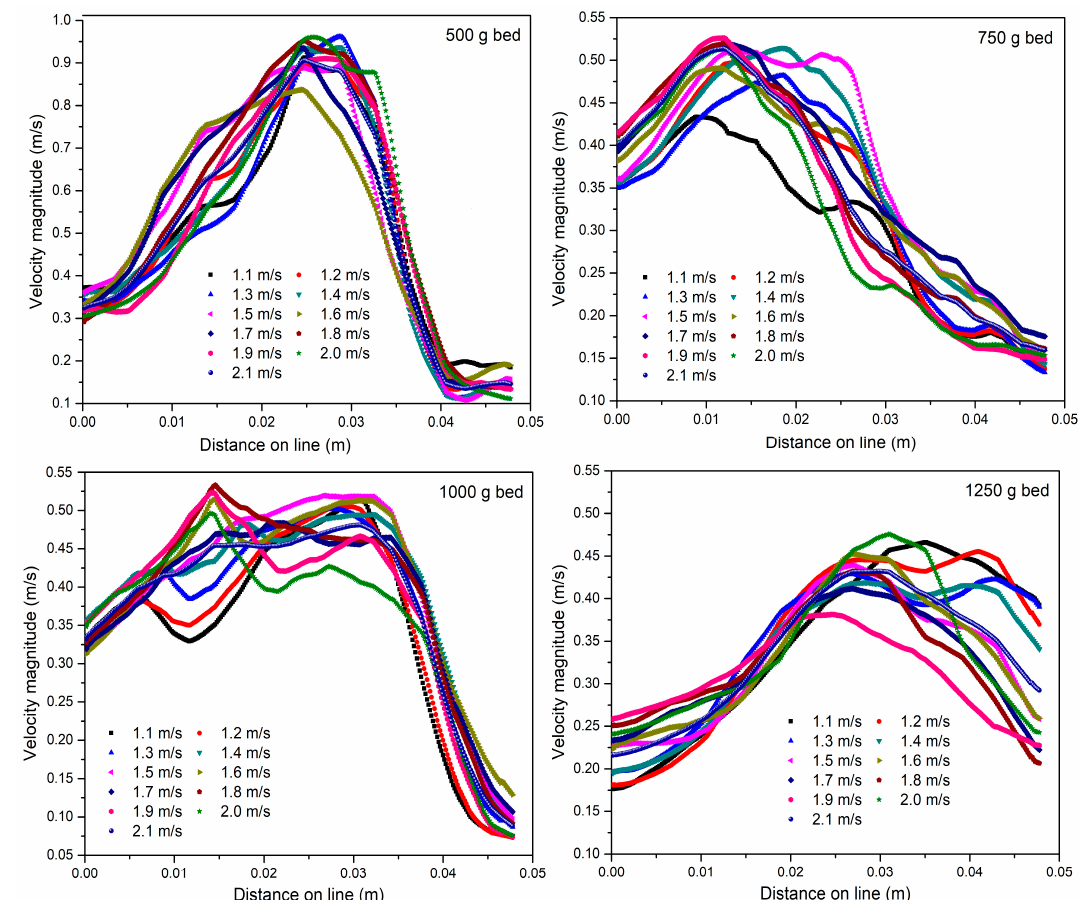
Figure 9. Trend of bed velocity magnitude on radial lines for different superficial velocities.